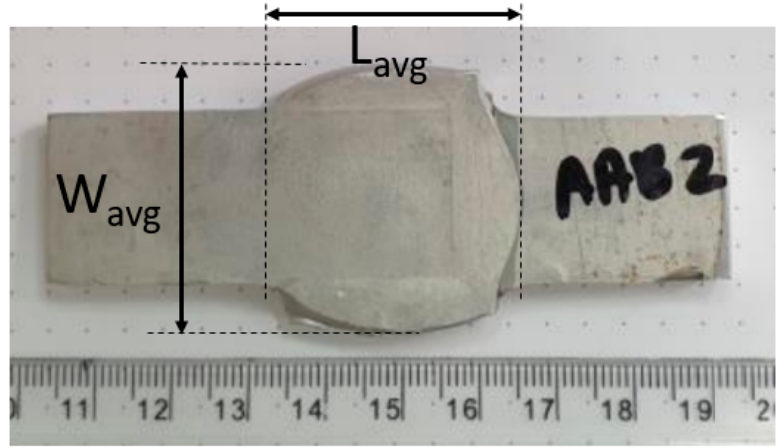
Figure 3. Representative measurements of the overlapping area.